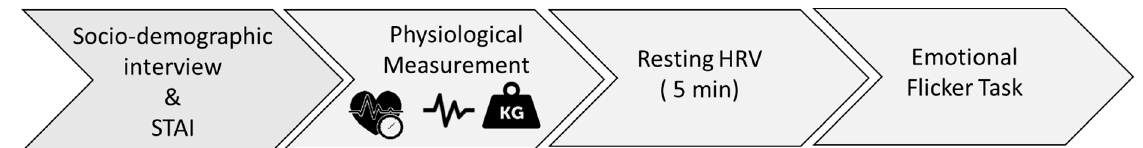
Figure 2. General procedure. STAI: State-Trait Anxiety Inventory; HRV: Heart Rate Variability.